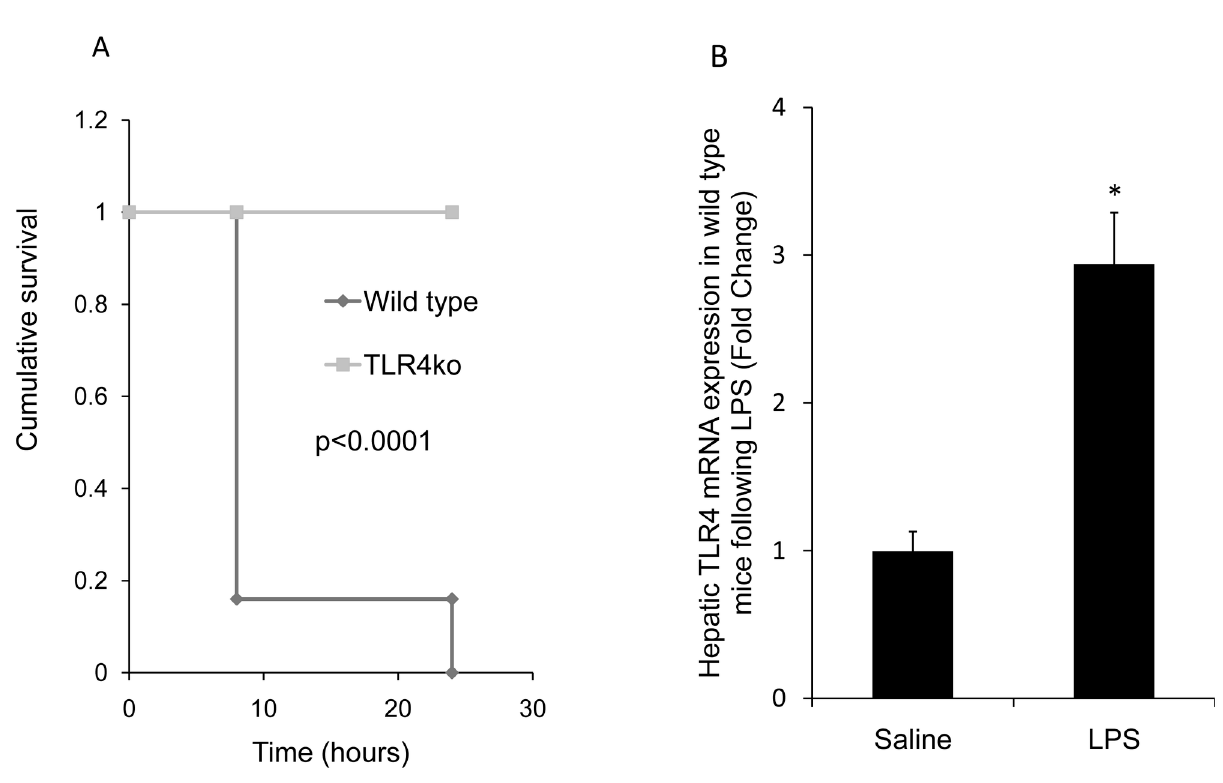
Figure 1. A: Kaplan-Meier survival curve. While 5/6 mice (83%) were treated with LPS died in less than 8 hours and the sixth died within the first 24 hours, all TLR4KO mice (6/6) survived following LPS (Kaplan-Meier, p < 0.001). B: Real-time PCR analysis of hepatic TLR4 mRNA expression: The results are shown as the fold-change of the relative quantity of TLR4 mRNA normalized to TATA-box mRNA values. TLR4 mRNA expression significantly increased 3-fold compared with saline administration in WT mice, 4 hours following LPS administration (*p ≤ 0.005); results are expressed as mean ±SE, n=4 in each group. doi: